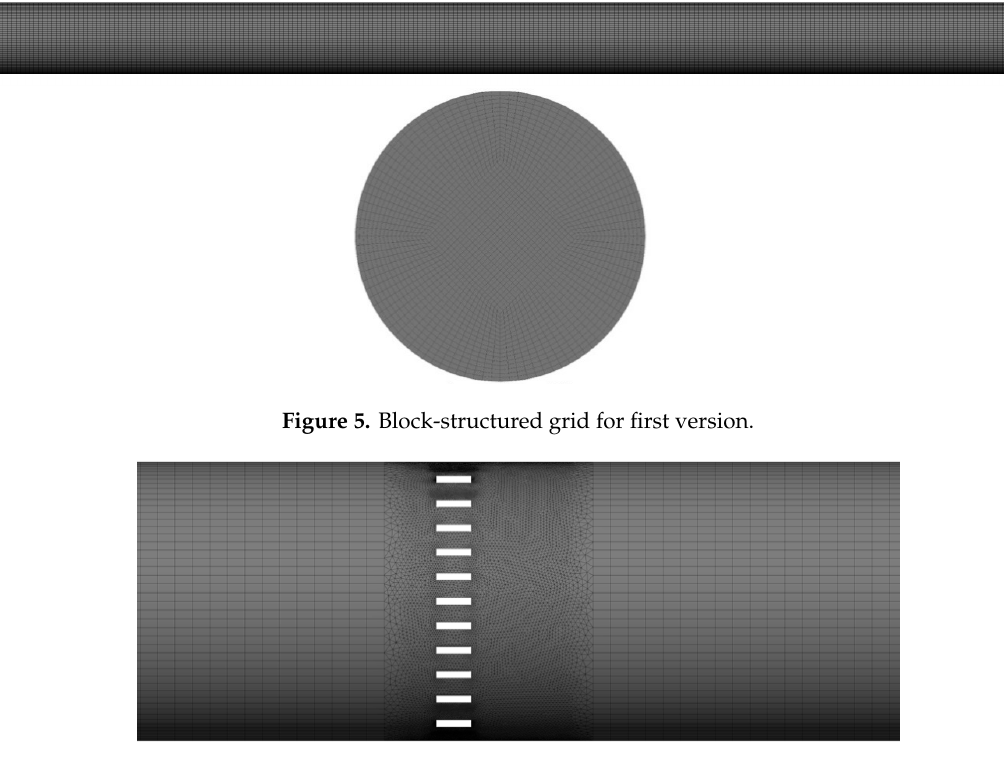
Figure 6. Hybrid mesh for second version.